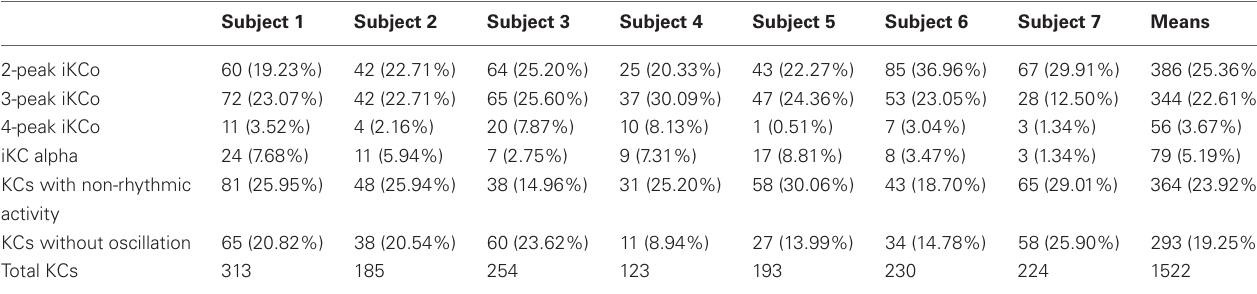
Table 1 | Group percentages of the number of KCs identified during the whole-night sleep of the